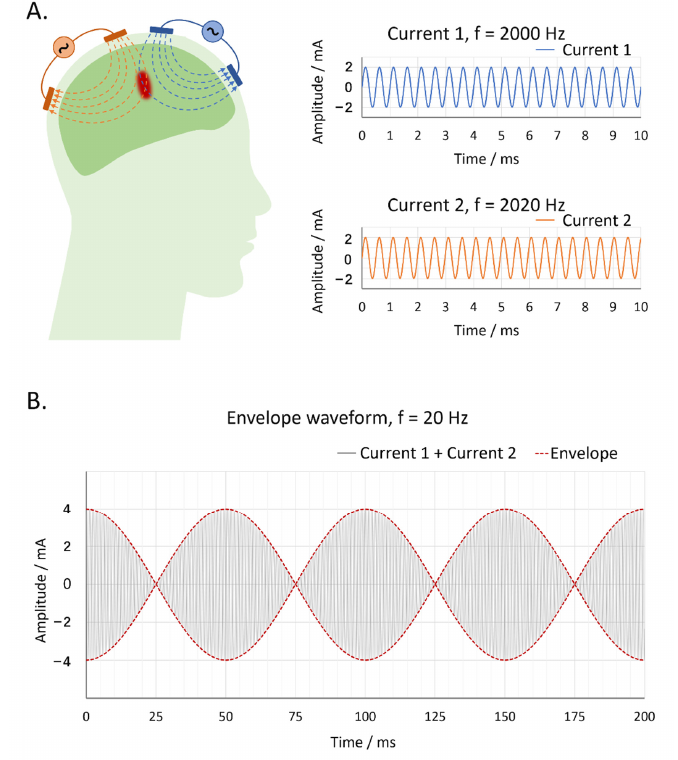
Figure 1. Schematic diagram of TI-tACS. ( A ) Stimulation of a specific area in the deep brain by TI-tACS, which has two pairs of electrodes with high-frequency alternative currents (e.g., 2000 Hz and 2020 Hz). ( B ) Low-frequency envelope-modulated current waveform of TI-tACS (e.g., 20 Hz) that is generated by the superposition of the two high-frequency current waves shown in ( A ). TI-tACS: temporal interference transcranial alternating current stimulation.